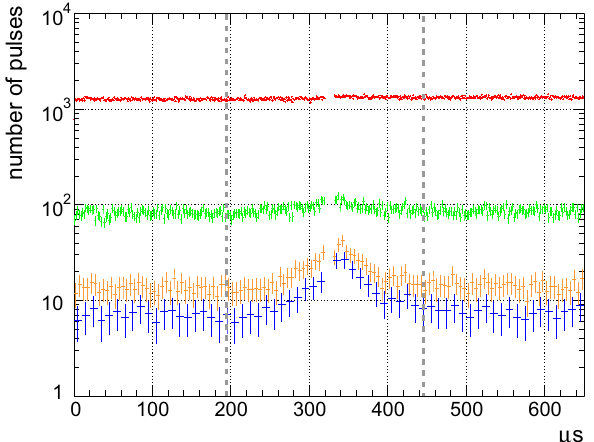
Fig. 6 Arrival time of pulses in the neighbourhood ( ± 320 µ s) of the trigger signal. Different colours represent different trigger thresholds: 3 MeV (red), 4 MeV (green), 5 MeV (orange) and 6 MeV (blue). Dashed grey lines separate the signal region (in the center) from the background ones